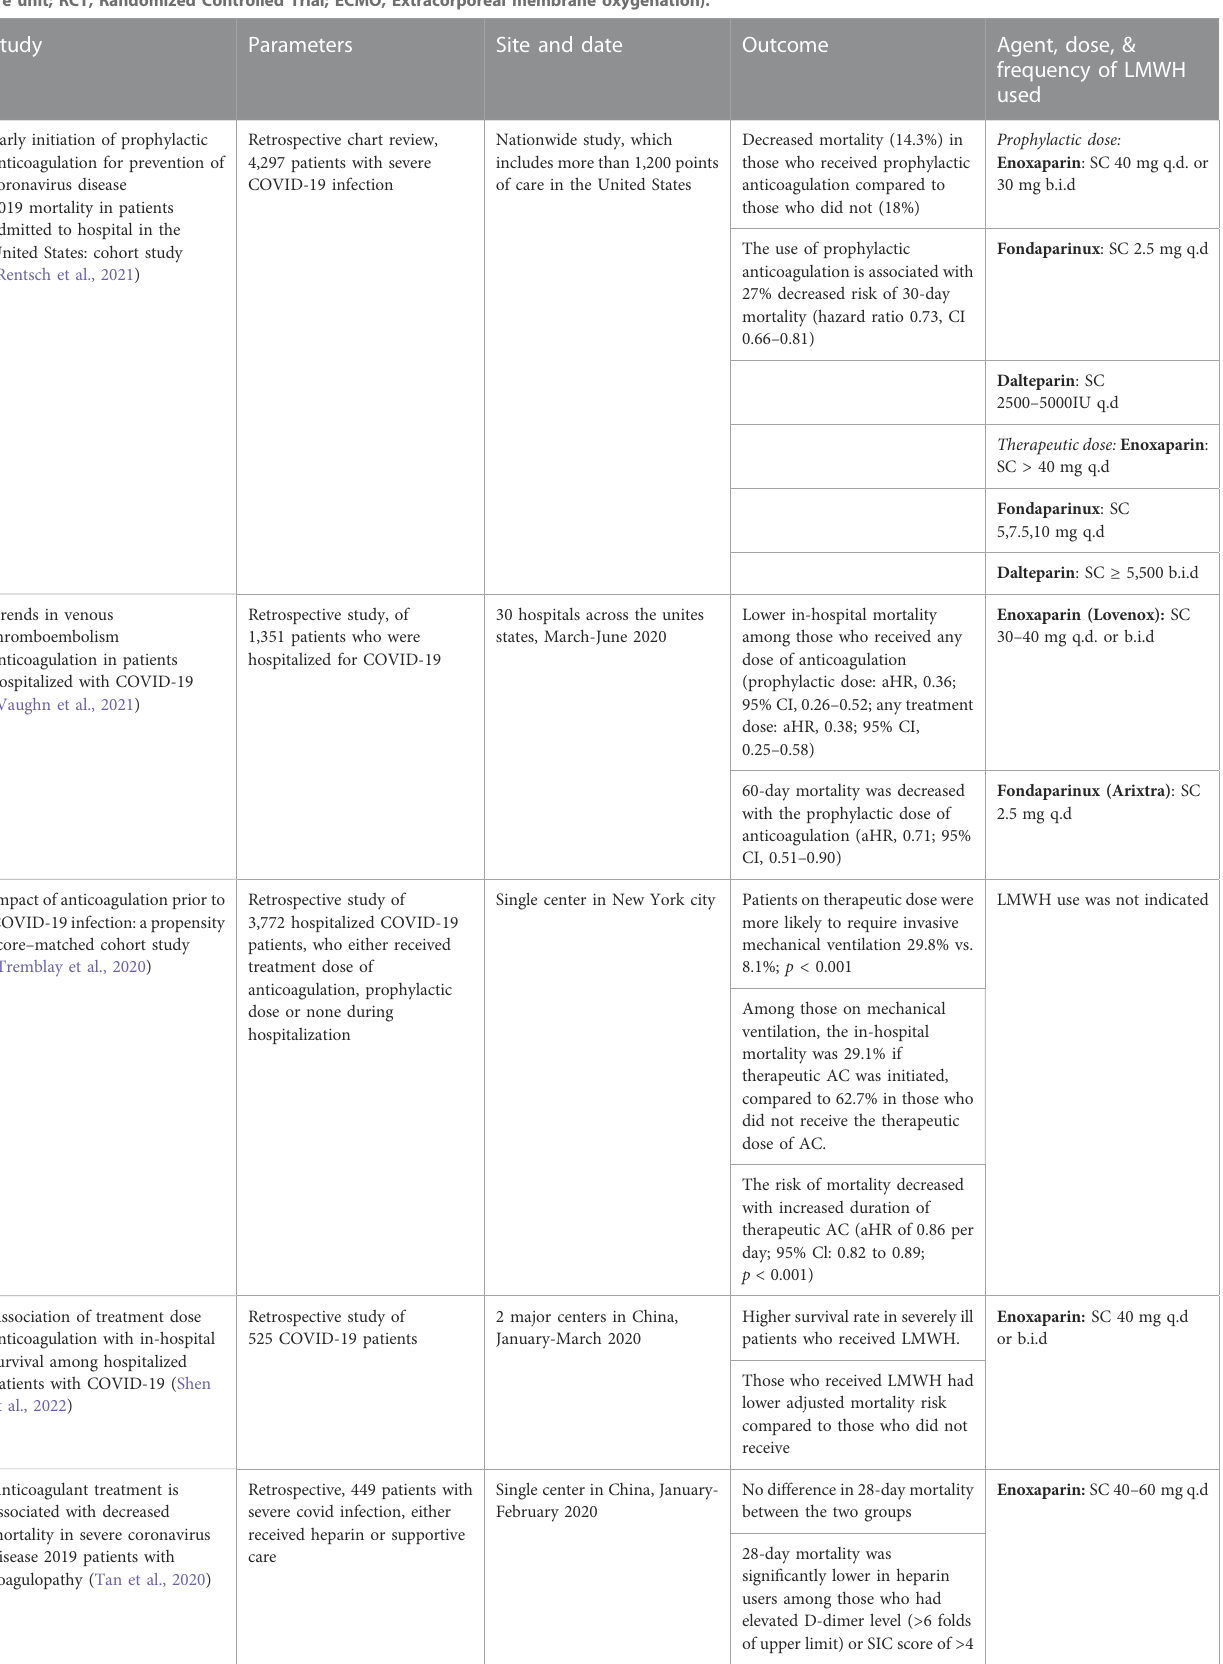
TABLE 1 The high impact studies tackling anticoagulation in COVID-19. (aHR, adjusted hazard ratio; CI, Con fi dence interval; AC, anti-coagulation; ICU, intensive care unit; RCT, Randomized Controlled Trial; ECMO, Extracorporeal membrane